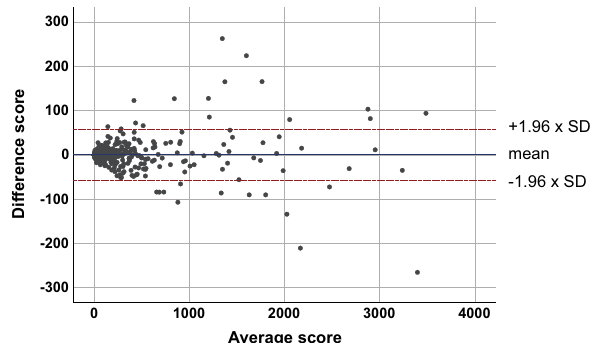
Figure 2. Bland–Altman plot between the standard and modified CAC scores from the training set (n = 680).